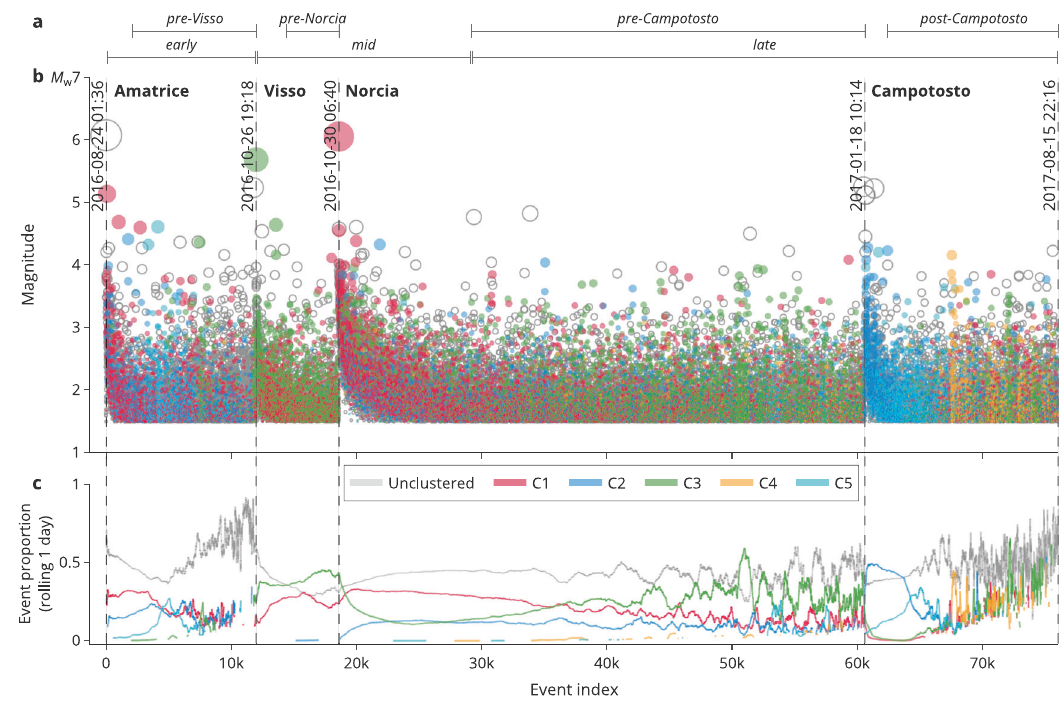
Fig. 2 | Temporal evolution of CI2016 seismicity colored by cluster associa- tion (see legend). The horizontal axis represents the index of the shown earth- quakes. a Overview of the temporal subsets. b Magnitude vs. index of individual events (empty circles denote ‘ unclustered ’ ); the occurrence times of main events